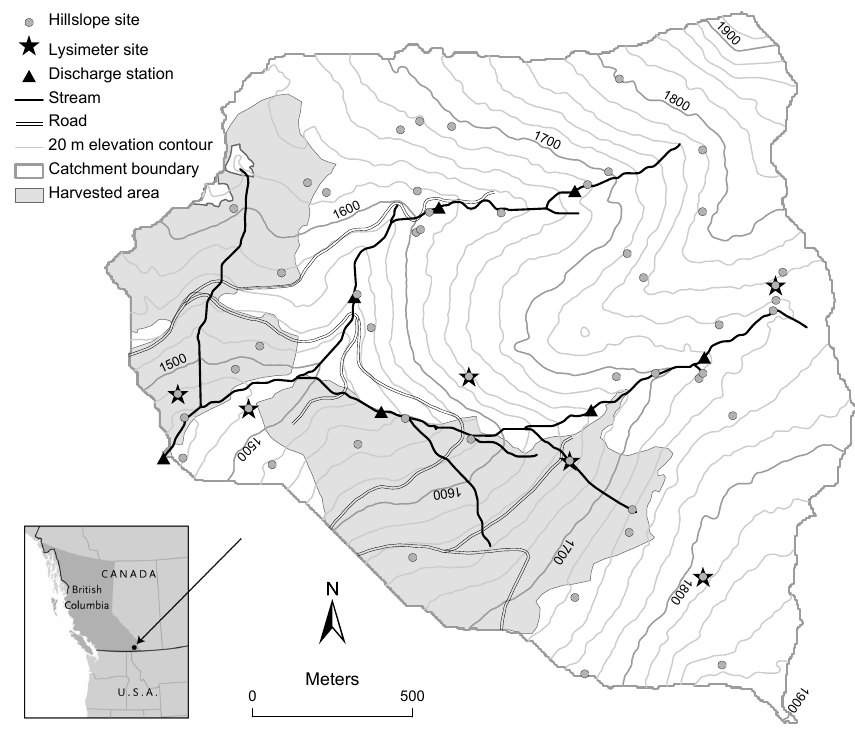
Figure 1. Location and study sites of the Upper Elk Creek